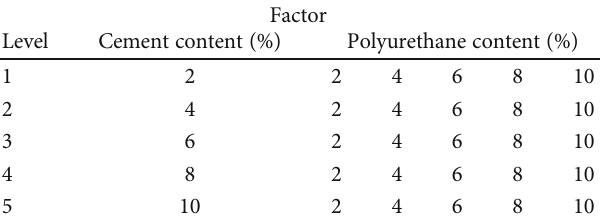
Table 1: Experimental proportioning